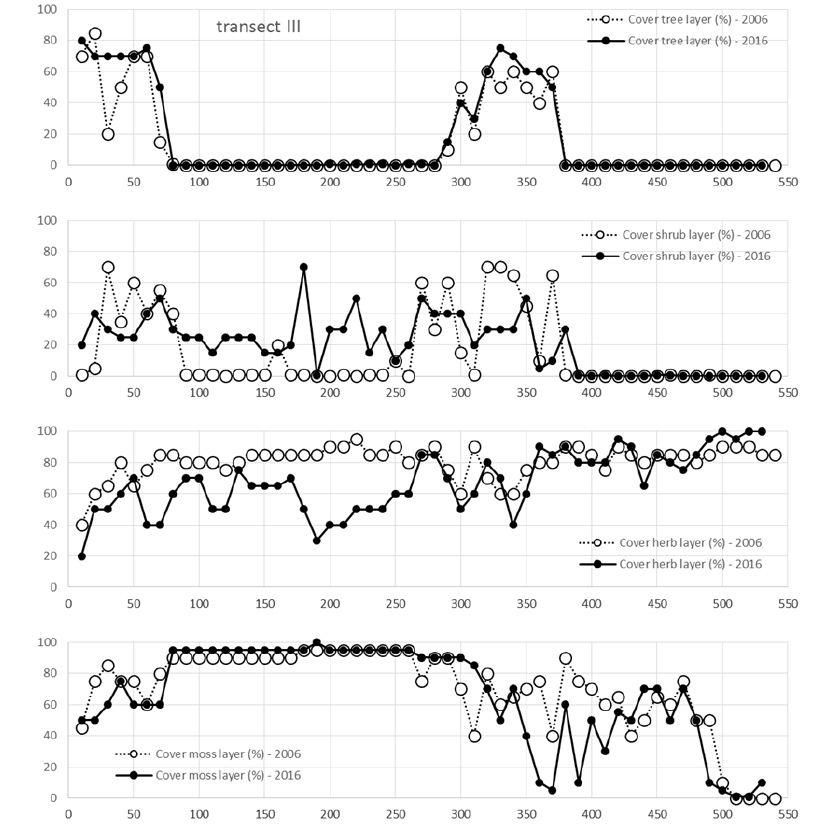
Figure 5. Cover of tree, shrub, herb and moss layers along Transect III, in 2006 and 2016.